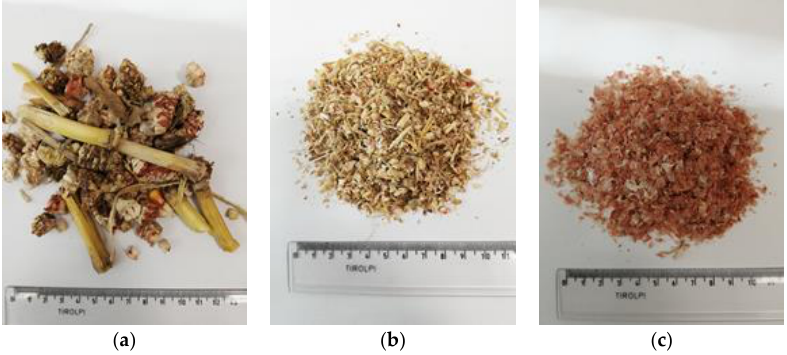
Figure 1. Material used in the study before mixing: ( a ) corn cobs (CCs), ( b ) corn grains (CGs), ( c ) corn husks (CHs).